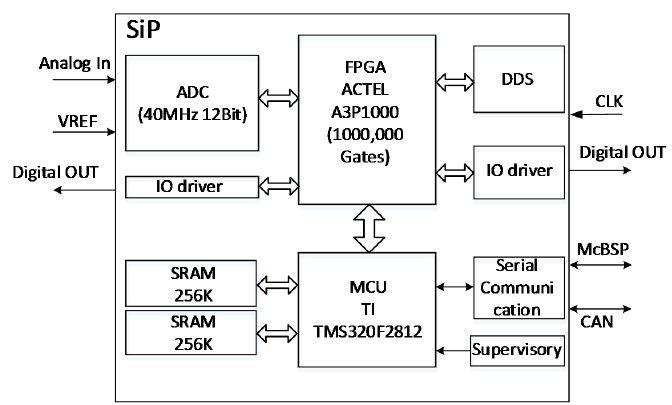
Figure 5. Components of the SiP.